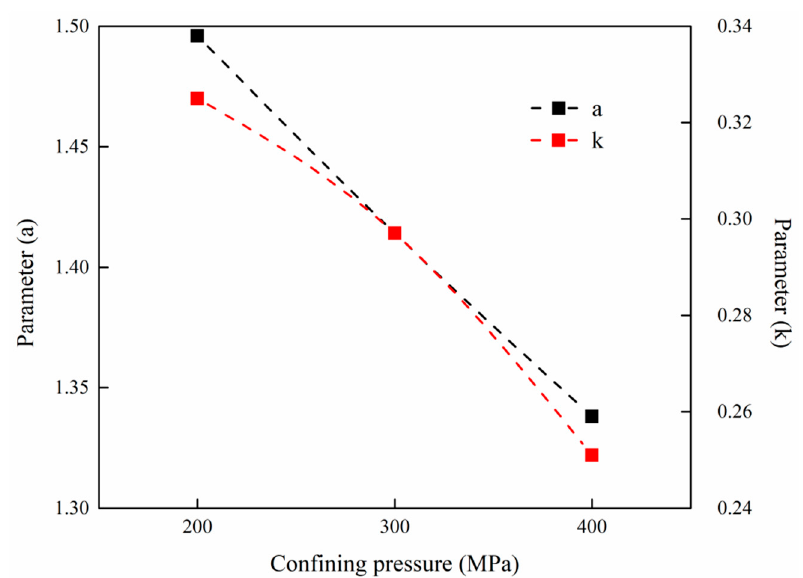
Figure 15. Parameter changes.